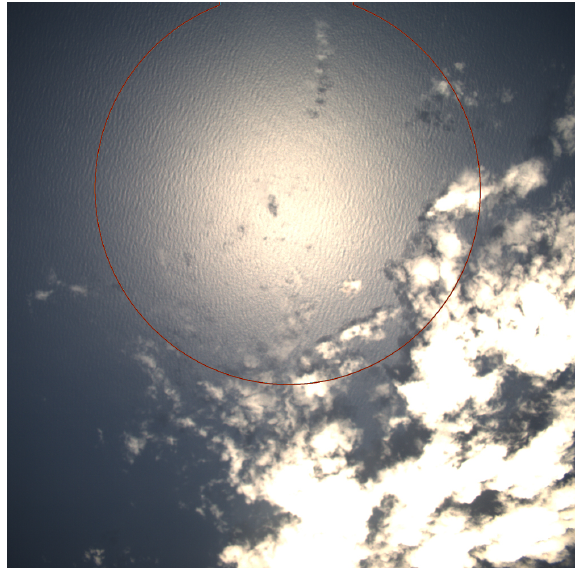
Figure 3. At low latitudes, close to local noon as on the NARVAL- II flight RF07 (19 August 2016, 15:06:13UTC), the specular re- flection of the sun on the ocean surface (sunglint) produces bright spots and high contrasts on the waves tails. While the bright spots can visually hide clouds, the contrasts create useless initial tracking points. The latter are mitigated by calculating the region of a poten- tial sunglint (shown as red contour) and masking that region before the images are processed.